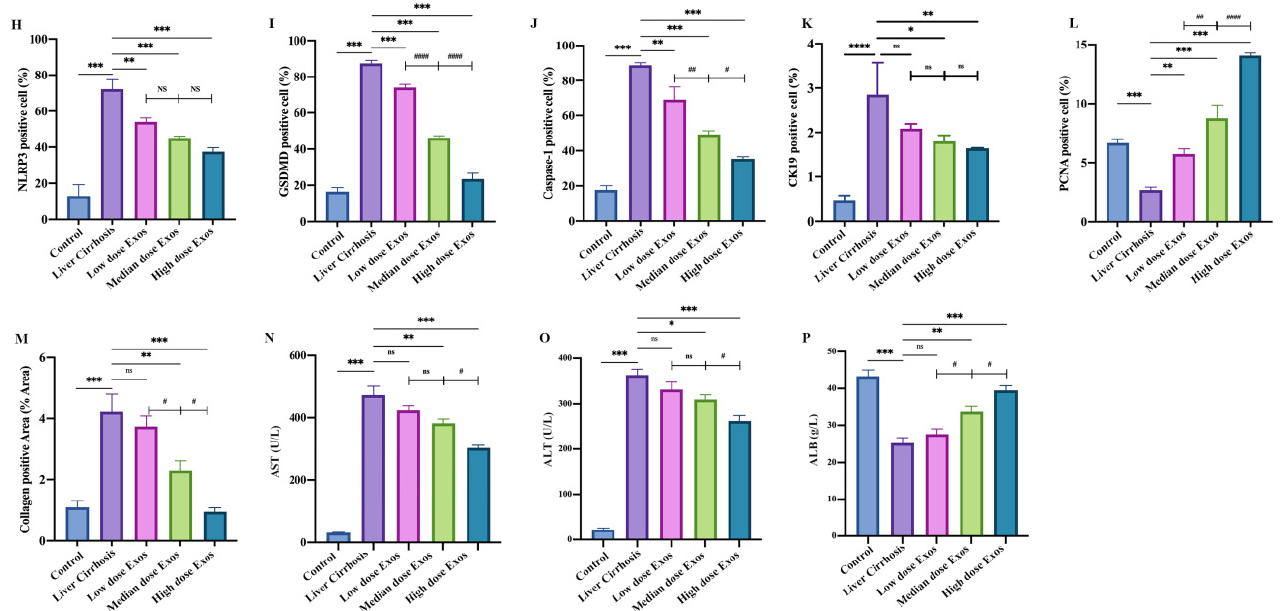
Figure 5. The therapeutic effect of Exo-BMMSC on liver cirrhosis was assessed in pathological sections and by measuring liver function. HE-stained sections from the control, liver cirrhosis and exosome treated groups are shown ( A ). Masson-stained sections from the different treatment groups are shown ( B ). Semi-quantitative analysis of the collagen-positive area showed that the areas in the medium dose and the high dose Exos-rBMMSC groups were significantly decreased compared with those in the liver cirrhosis group (( M ), ** p < 0.01). The collagen area in the medium dose Exos group was significantly lower than that in the low dose Exos group but was higher than that in the high dose Exos